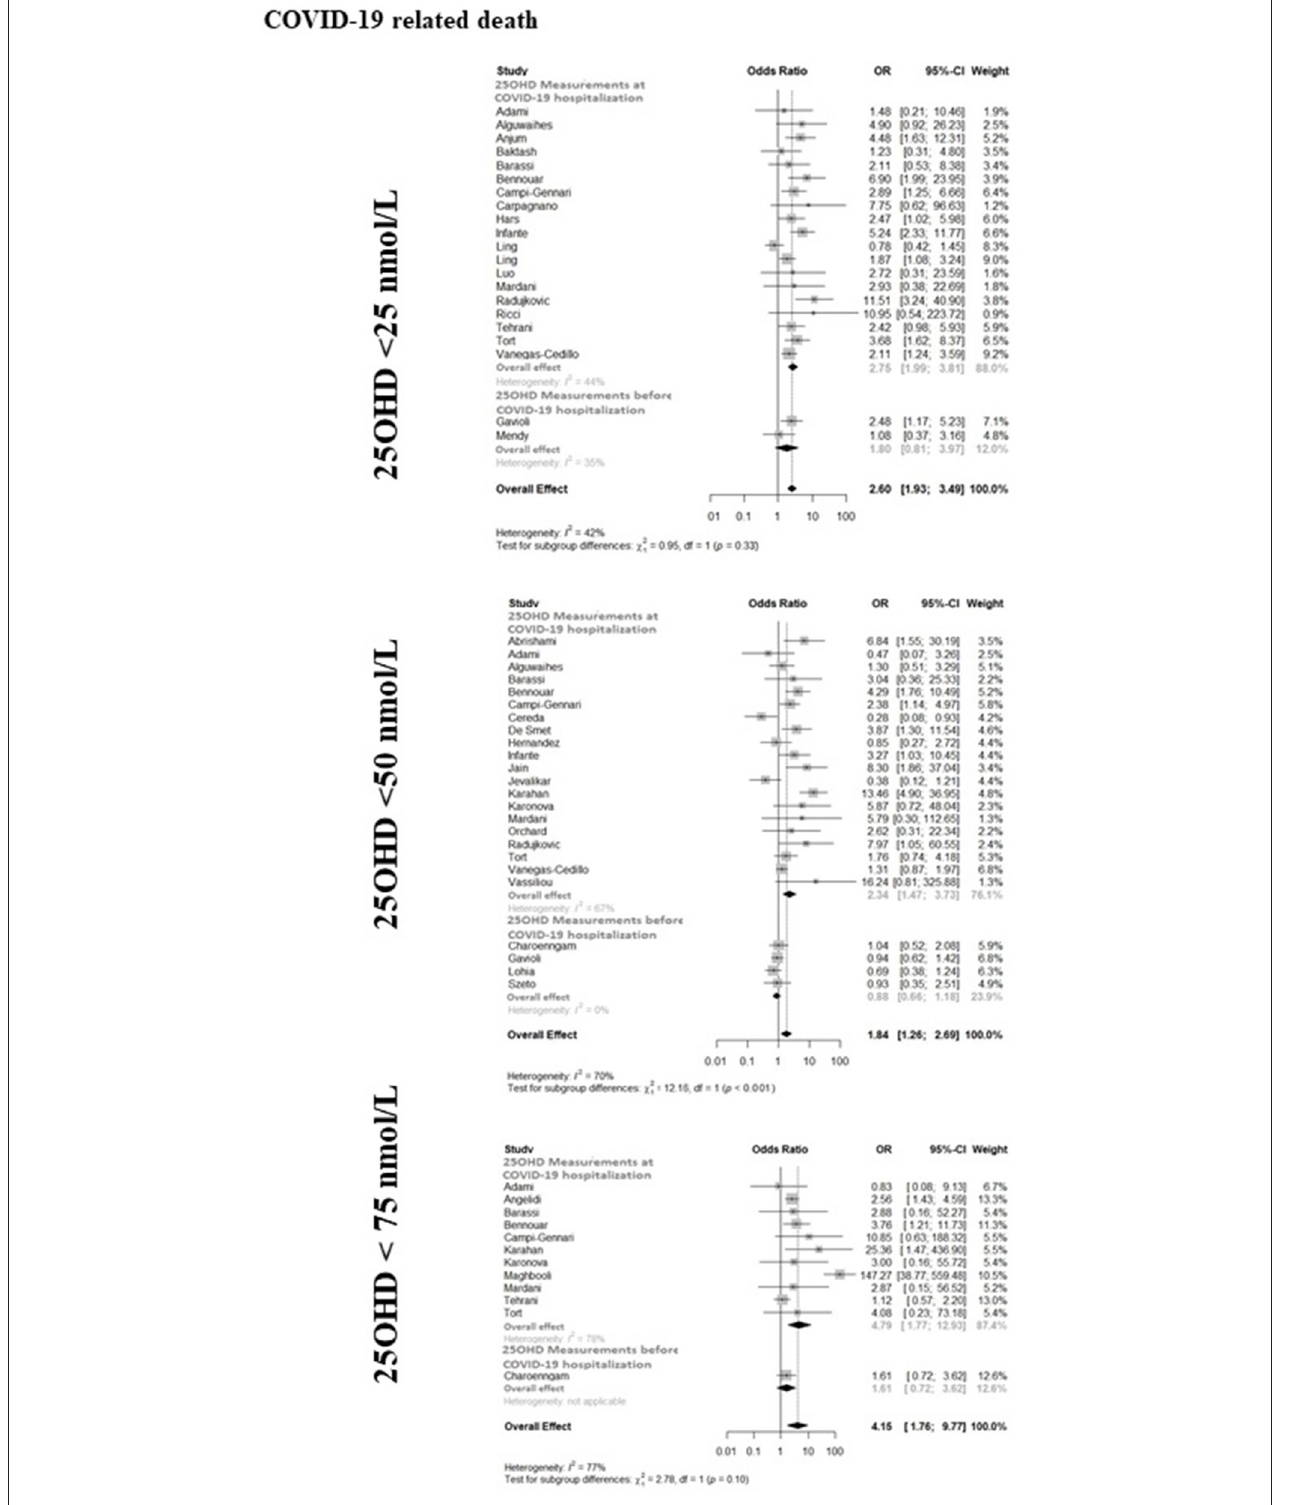
FIGURE 3 | The forest-plot reporting the association between COVID-19 related mortality and vitamin D thresholds (severe vitamin D deficiency, vitamin D deficiency, and vitamin D insufficiency). COVID-19, Coronavirus Disease-2019; ICU, intensive Care Unit; < 25 nmol/L, 25OHD levels below 25 nmol/L; < 50 nmol/L, 25OHD levels below 50 nmol/L; < 75 nmol/L, 25OHD levels below 75 nmol/L.